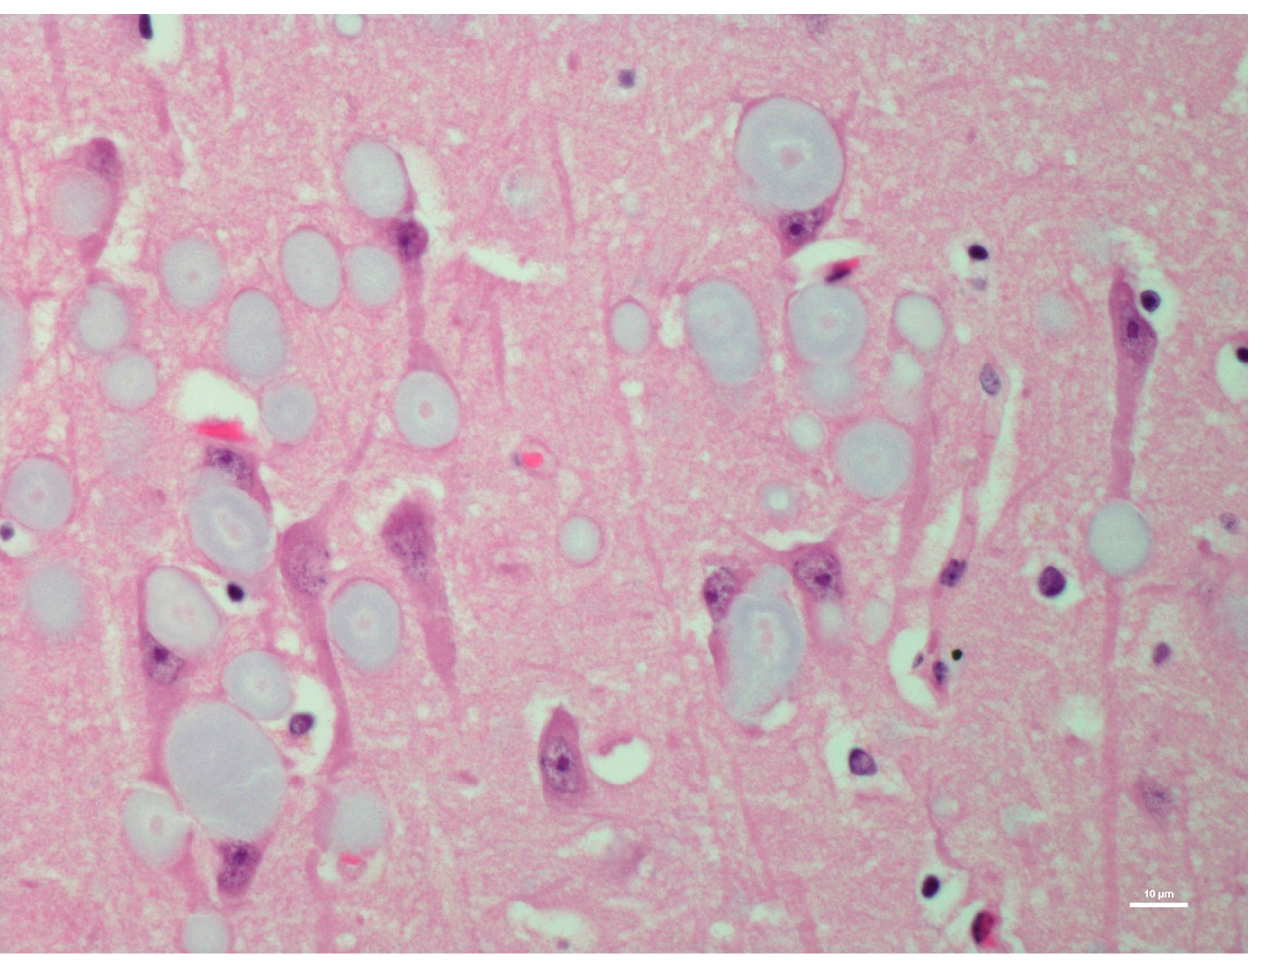
Figure 1. Hematoxylin and eosin (H&E)-stained section of hippocampus region of the brain of a moose showing round polyglucosan bodies (PGBs) in the perikaryon, neuronal processes, and neuropil. Note the outer pale layer and basophilic core.